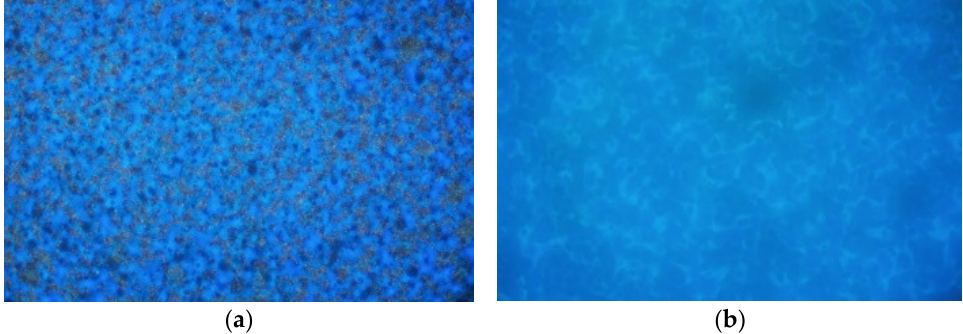
Figure 11. Fluorescent micro-structure of WE/A with 30% WER ( a ) 1 h; ( b ) 48 h.